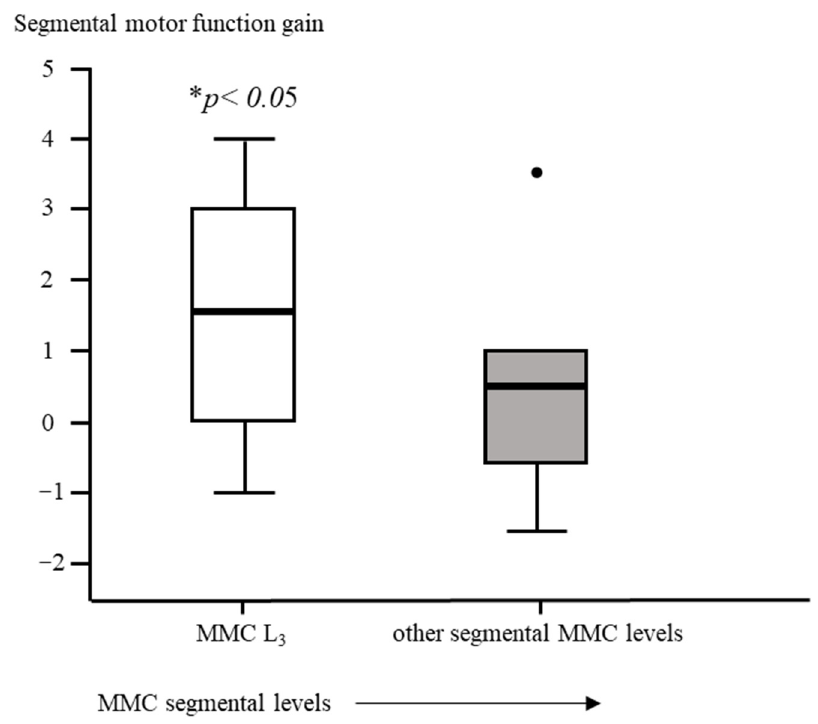
Figure 6. Intervention-related difference in segmental motor function between fetally and neonatally operated children subdivided per MMC-level. The x-axis represents a subdivision of MMC levels of L3-L4 or other. The y-axis represents the difference in segmental motor levels between fetal and neonatal MMC operations. Segmental motor function gain is determined by the difference in segmental motor function level between age- and lesion-matched pairs of fetal versus neonatal operations. Fetally operated children represent OSBAR and FSBAR intervention groups together. Fetally operated children with an MMC at L3-L4 revealed significantly more segmental motor function gain (* p < 0.05) than other lesions. Box plots mark the first and third quartiles; whiskers represent data points 1.5 times the interquartile range below and above the first and third quartiles. Dots represent outliers. MMC = myelomeningocele.